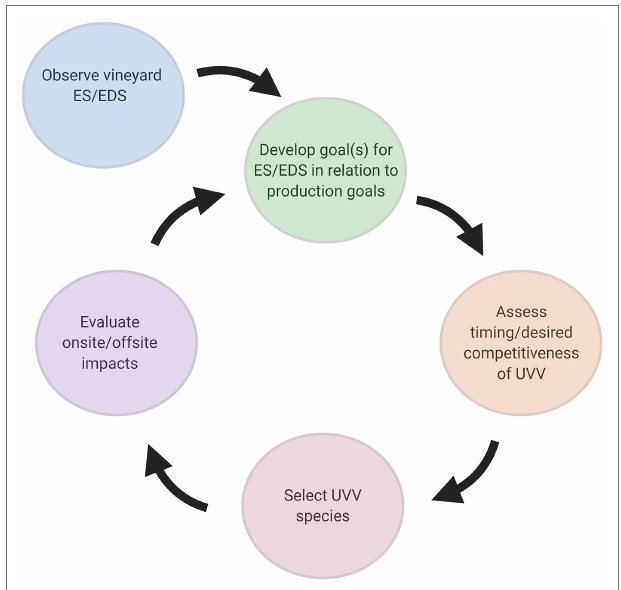
FIGURE 4 | Iterative framework for adoption of UVV. ES, ecosystem services; EDS, ecosystem disservices. Figure created with